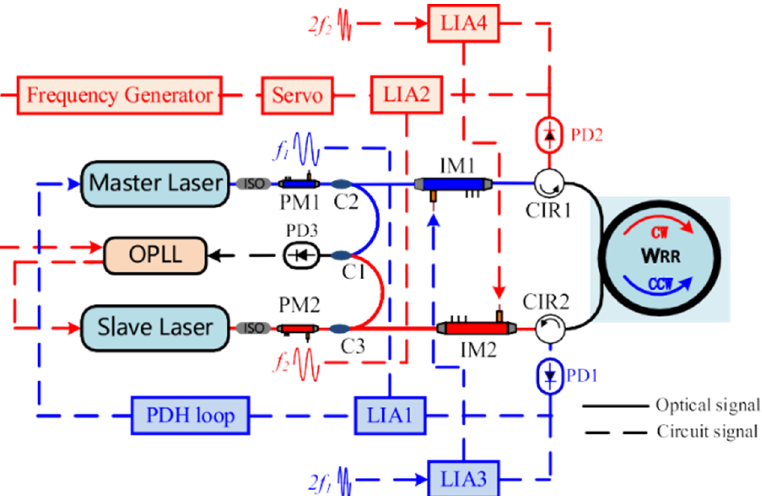
Figure 6. The configuration of the RIOG based on double light sources. PDH: Pound–Drever–Hall; ISO: isolator; IM: intensity modulator. Hall; ISO: isolator; IM: intensity modulator. Reprinted with permission from ref. [22]. Copyright 2021